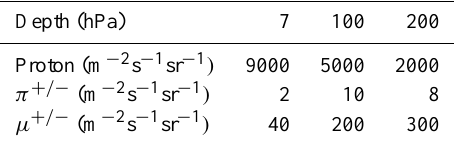
Table 1. Vertical flux of protons, pions and muons, integrated in en- ergy, at the atmospheric depth corresponding to the Martian surface.